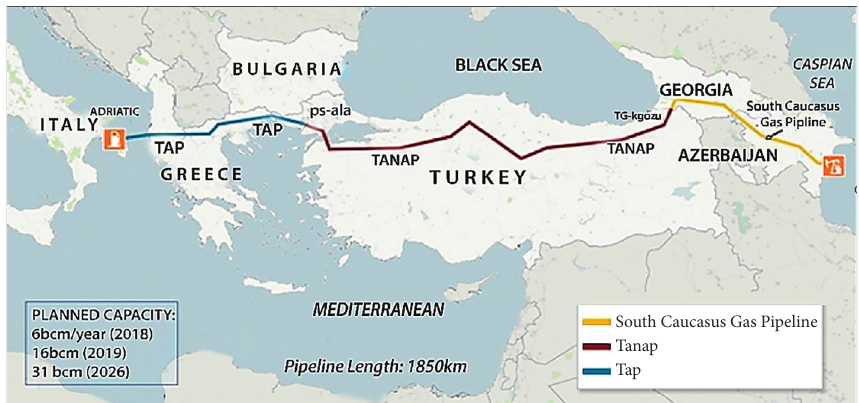
Figure 10: TANAP and TAP pipeline